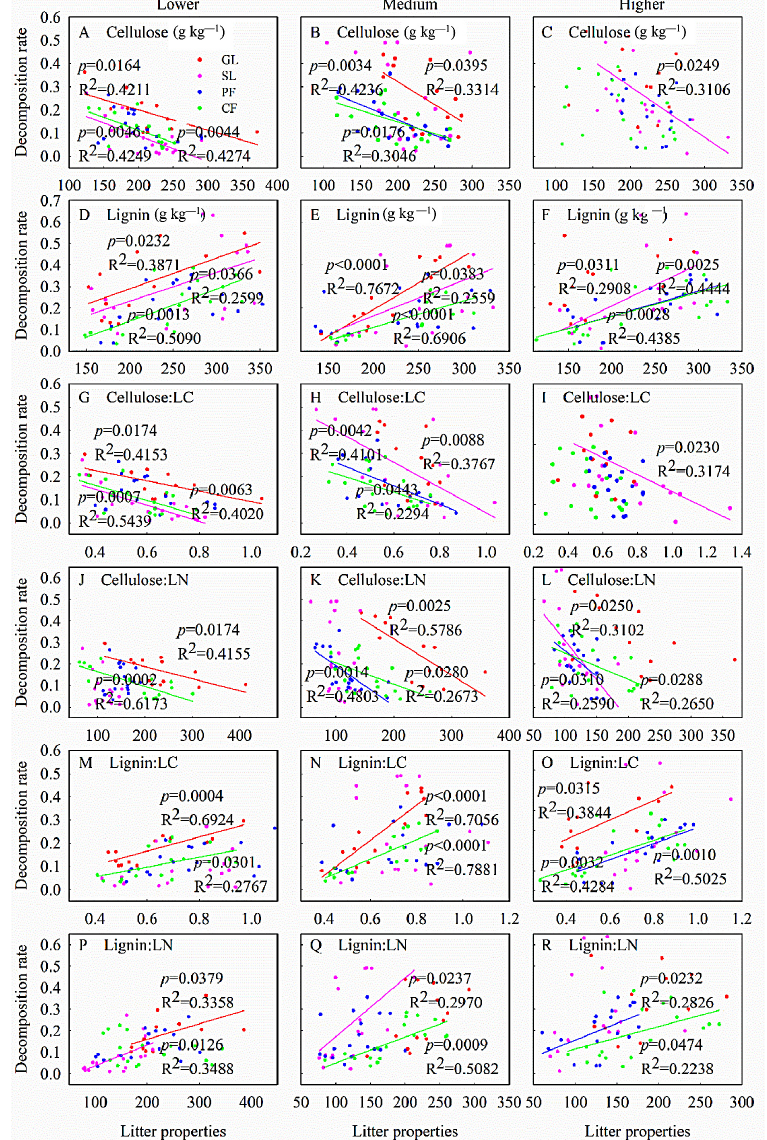
Figure 5. Correlation between cellulose, lignin and litter decomposition rate. LC: litter carbon, LN: litter nitrogen. Lines not shown in the figure indicate no correlation ( p > 0.05). GL, grassland; SL, shrubland; PF, pioneer forests; CF, climax forests. ( A – C ) represent the correlation between litter decomposition rate and cellulose under lower water, medium water, and higher water treatments, respectively; ( D – F ) represent the correlation between litter decomposition rate and lignin under lower water, medium water, and higher water treatments, respectively; ( G – I ) represent the correlation between litter decomposition rate and cellulose: LC under lower water, medium water, and higher water treatments, respectively; ( J – L ) represent the correlation between litter decomposition rate and cellulose: LN under lower water, medium water, and higher water treatments, respectively; ( M – O ) represent the correlation between litter decomposition rate and lignin: LC under lower water, medium water, and higher water treatments, respectively; ( P – R ) represent the correlation between litter decomposition rate and lignin: LN under lower water, medium water, and higher water treatments, respectively.